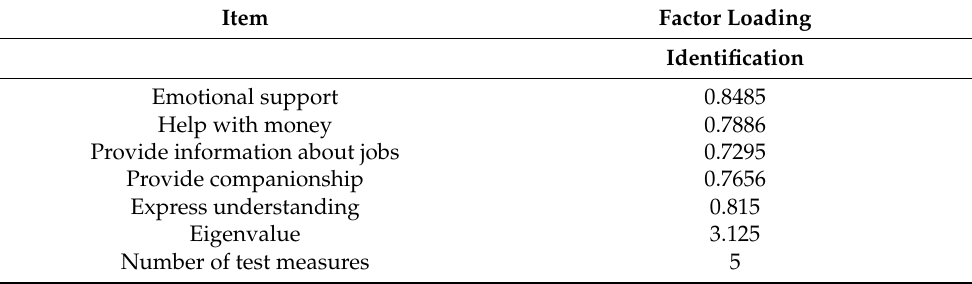
Table 4. Summary of results from exploratory factor analysis of bonding social capital.